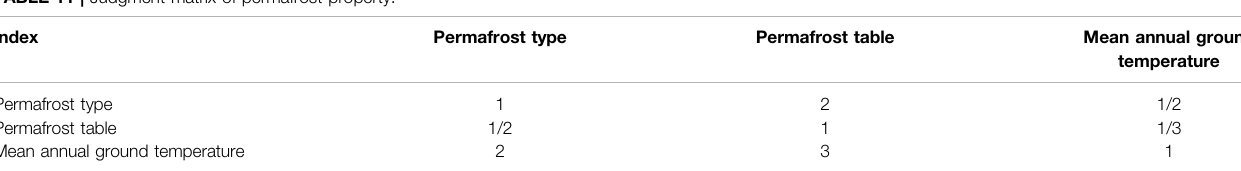
TABLE 11 | Judgment matrix of permafrost property.